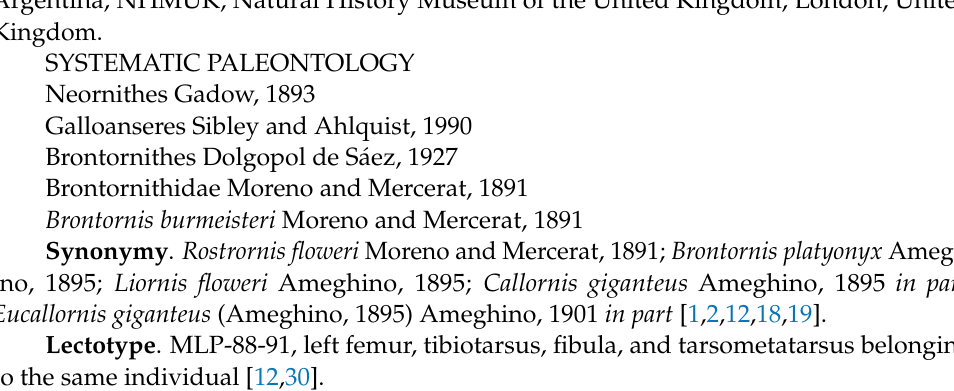
Figure 3. Brontornis burmeisteri (MLP 20-581) distal end of left tibiotarsus in ( A ) anterior; ( B ) poste- rior; ( C ) lateral; ( D ) medial; and ( F ) distal views; and ( E ) cross section of the shaft. Abbreviations . ct, central tubercle for the lig. meniscotibiale intertarsi ; df, distal fossa; eg, extensor groove; fi, surface